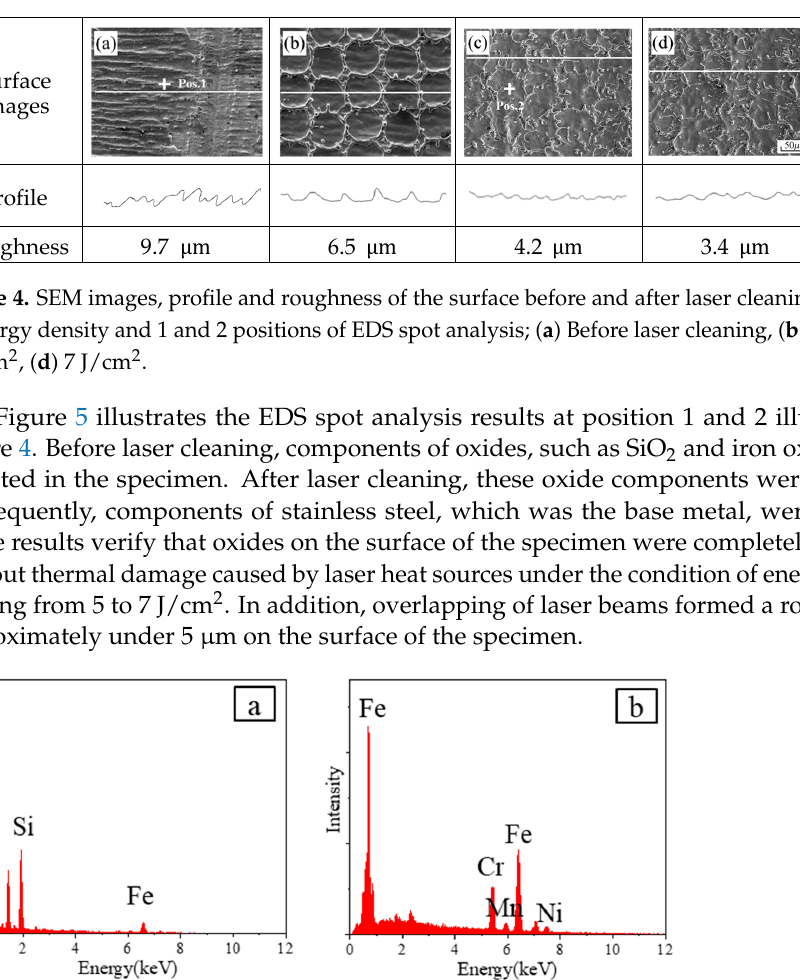
Figure 5. EDS spot analysis results at positions 1 and 2 shown in Figure 4; ( a ) Pos. 1, ( b ) Pos. 2.